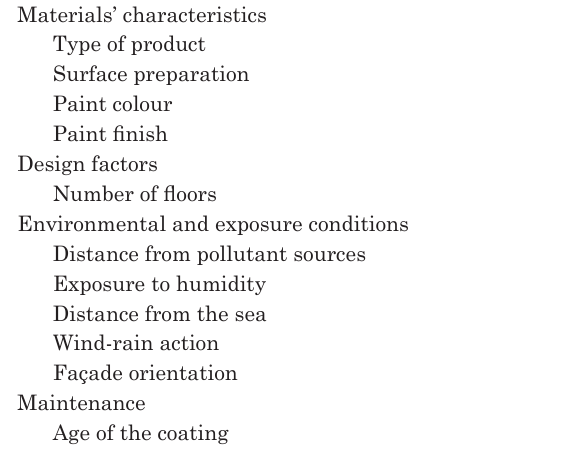
Table 1. Decomposition of the degradation factors into variables, which can be identified in field work Materials’